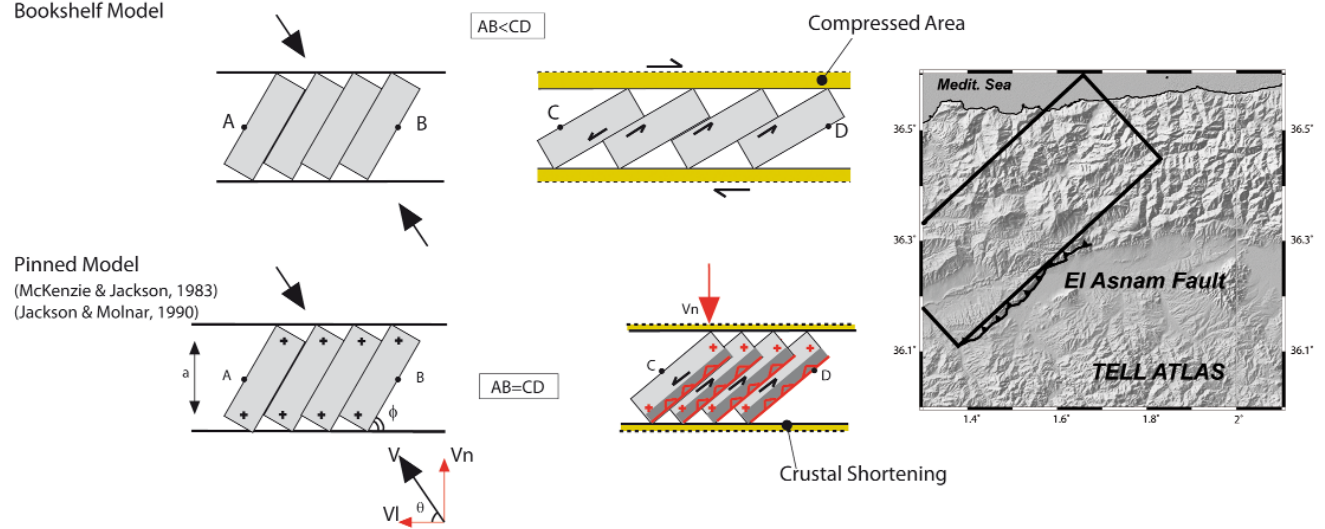
Figure 4. Upper panels: Kinematic model of a deformed zone with small-block rotation and lateral extension [Lamb 1987, Jackson and Molnar 1990]. Lower panels: pinned model where the slip vector V = Vn + Vl and with no lateral extension within the deforming zone. The difference between the bookshelf and pinned models is illustrated by the different distances of CD in each case. The shortening angle b represents the ratio between the pure shear and lateral shear within the deforming zone, a -1 represents the shortening across the zone, and i is the convergence strike (see text). The shaded relief shows a schematic representation of a small tectonic block and the related El Asnam fault. The calculated compression-to-transcurrence ratios are given in Table